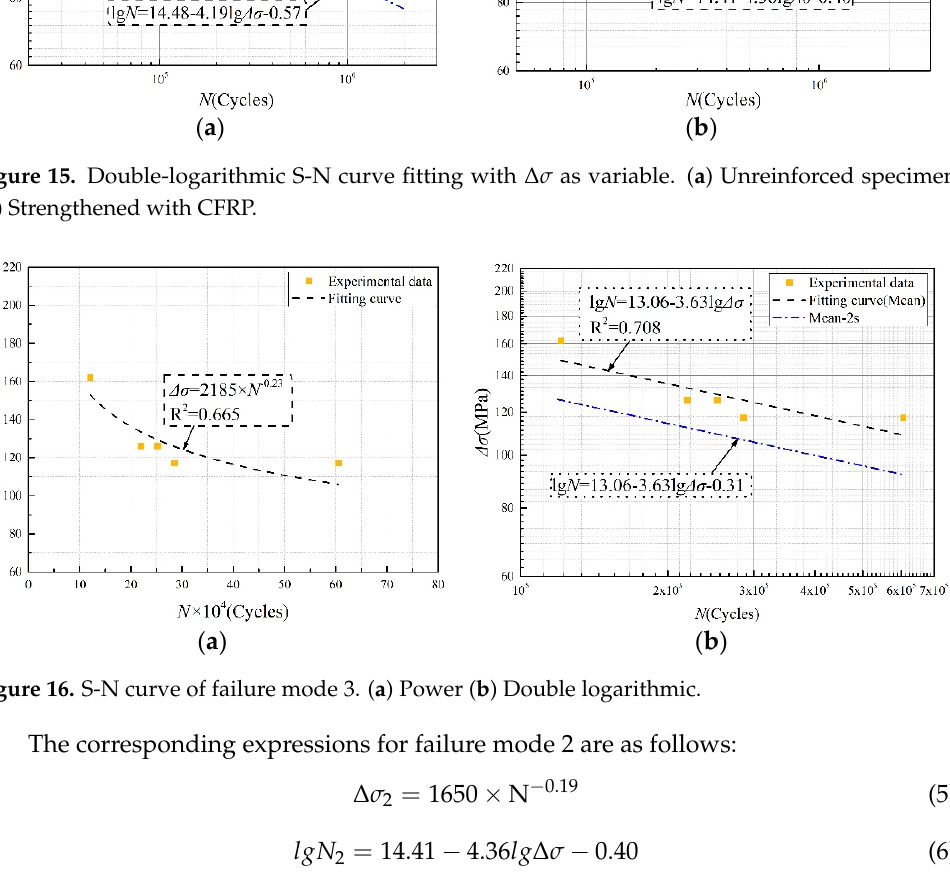
Figure 15. Double-logarithmic S-N curve fitting with ∆(cid:2026) as variable. ( a ) Unreinforced specimen ( b ) Strengthened with CFRP.